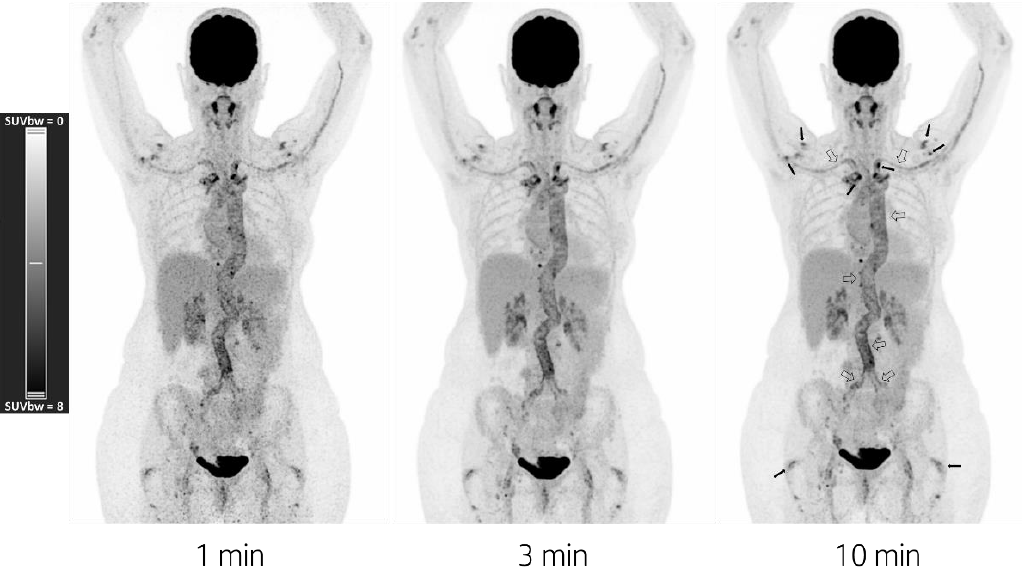
Figure 1. Maximum intensity projection PET images acquired for 1 min ( left ), 3 min ( middle ), and 10 min ( right ). Images were reconstructed using a vendor-recommended clinically optimized protocol for optimal image quality, consisting of 3D OSEM with 4 iterations, 5 subsets, a matrix size of 440 × 440 × 708 with a voxel size of 1.6 × 1.6 × 1.5 mm 3 , time-of-flight application, resolution modelling, and no filtering. Data were acquired using a maximum ring difference of 85. In all three images, ranging from very fast to standard acquisition time, one can see the following typical features of GCA and PMR: increased uptake in the aortic wall; the common iliac arteries; and the subclavian and axillary arteries due to GCA activity (hollow arrows in right image), and moderately to highly increased uptake around the shoulders, sternoclavicular joints, acromioclavicular joints, and greater trochanters due to PMR activity (filled in black arrows right